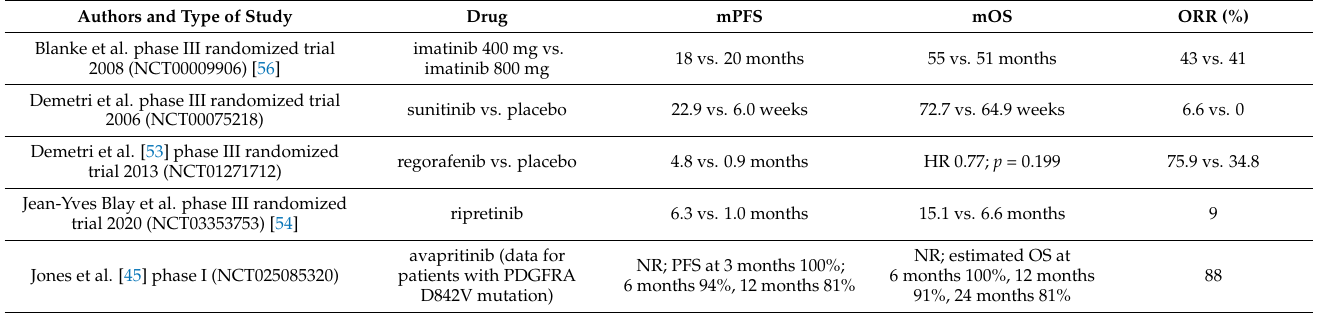
Table 2. Summary of the efficacy of drugs approved for treatment of unresectable and metastatic